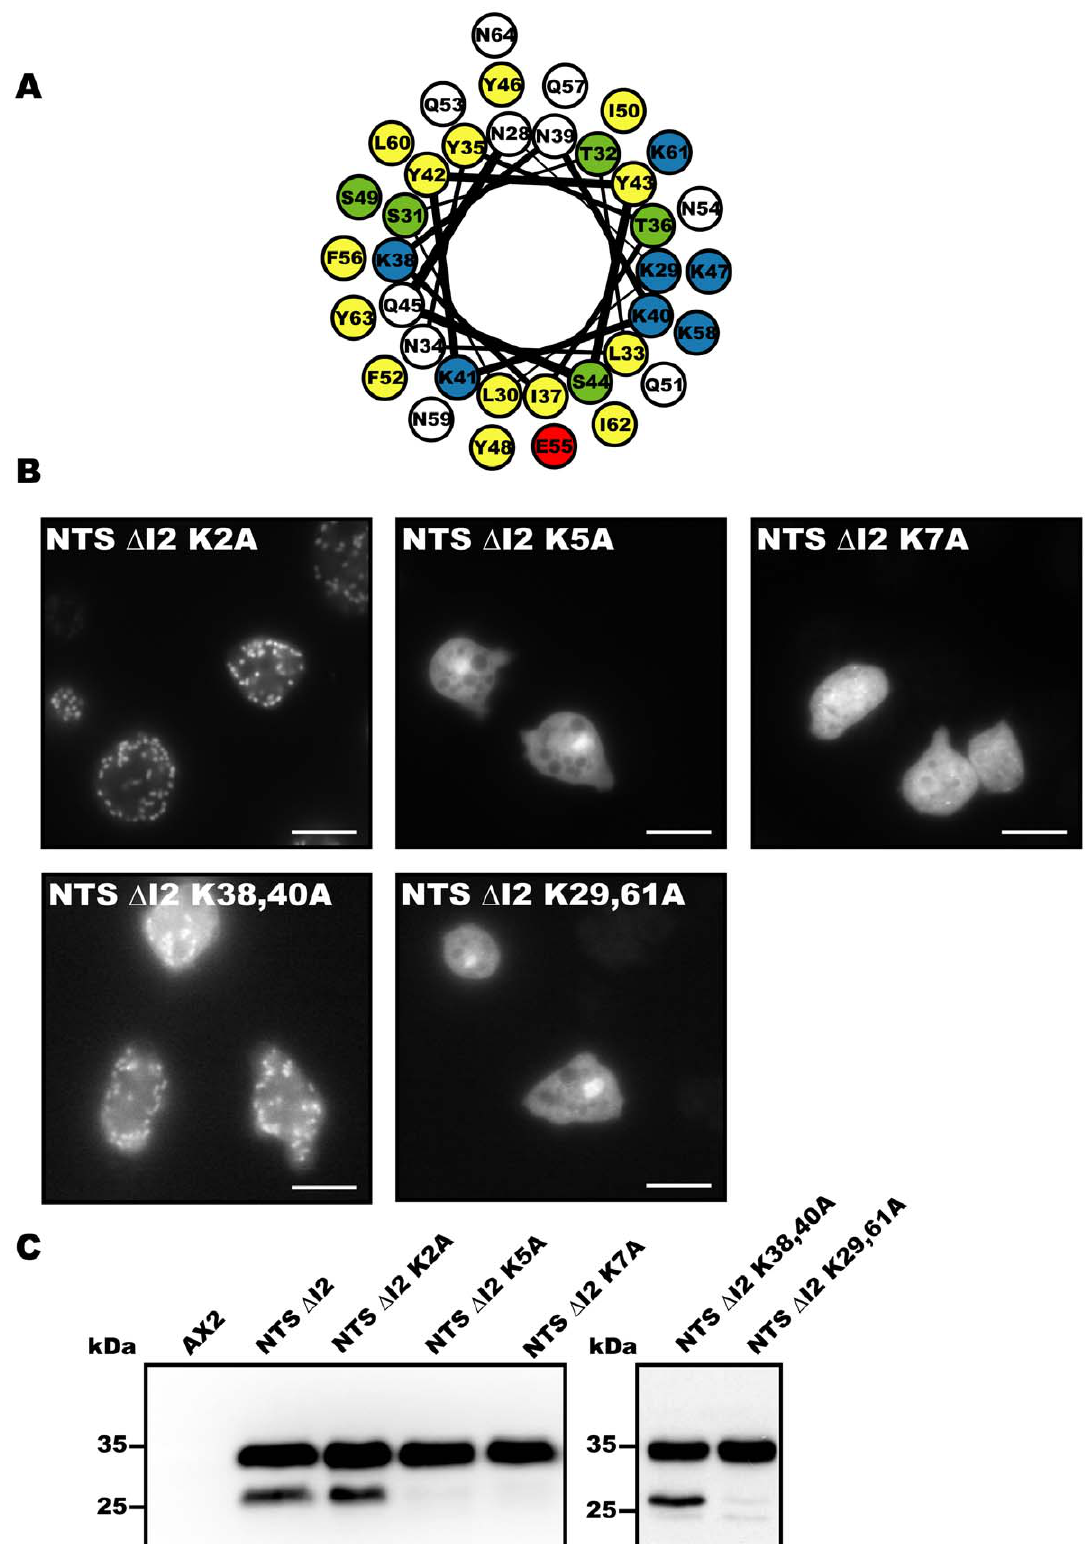
Figure 4. Positive charge clusters are essential for mitochondrial targeting. ( A ) Helical wheel projection of residues 28–64. Positively charged amino acid residues are shown in blue, negatively charged residues in red, serine and threonine in green and hydrophobic residues in yellow. ( B ) Localization of NTS D I2 mutants, NTS D I2–K2A, NTS D I2–K5A, NTS D I2–K7A, NTS D I2–K38A–K40A and NTS D I2–K29A–K61A. Diffuse staining indicates cytoplasmic distribution and granular staining mitochondrial targeting. Scale bars, 10 m m. ( C ) Immuno-blot loaded with D. discoideum